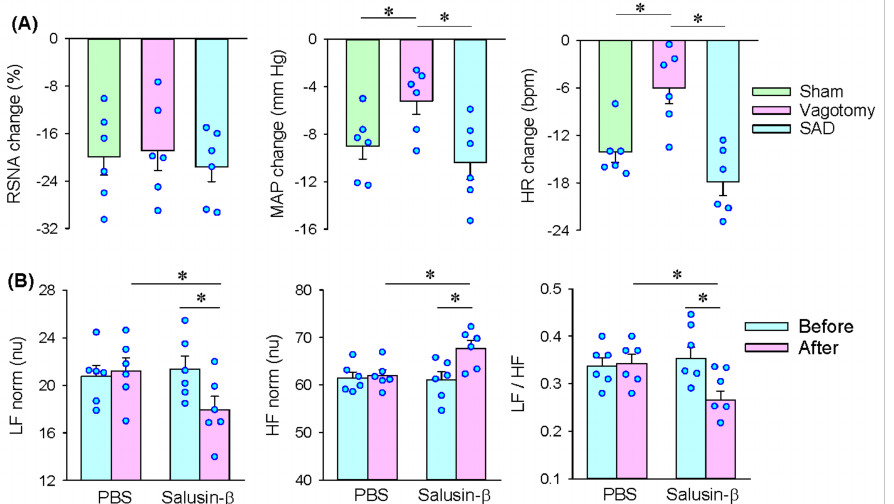
Figure 3. Roles of vagi in the effects of microinjection of salusin- β (100 pmol) in the iDMV. ( A ) Effects of bilateral vagotomy or sinoaortic denervation (SAD) on the roles of microinjection of salusin- β (100 pmol) in iDMV. ( B ) Effects of microinjection of salusin- β (100 pmol) in the iDMV on heart rate variability (HRV). nLF, normalized low frequency; nHF, normalized high frequency. * p <